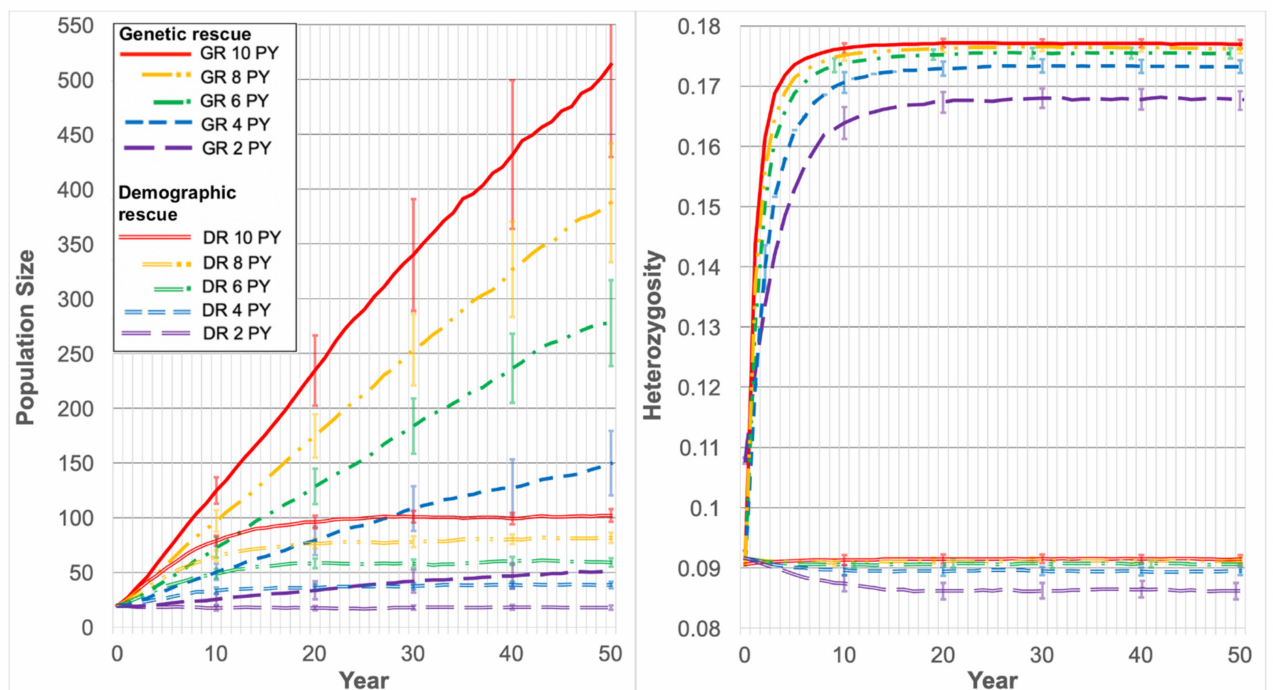
Figure 4. The mean population size ± 1 SD and heterozygosity ± 1 SD for simulations translocating two to ten individuals per year into the inbred lowland population, beginning with 20 lowland founders. Inbreeding depression as included in the models and K=1000. For genetic rescue (GR) scenarios, unrelated individuals were translocated from a simulated highland population. For demographic rescue (DR) scenarios, individuals were introduced with the same allele frequencies and mean pairwise kinships as individuals in the lowland population in 2019. Simulation settings are given in Table 1 ( Genetic Rescue and Demographic Rescue